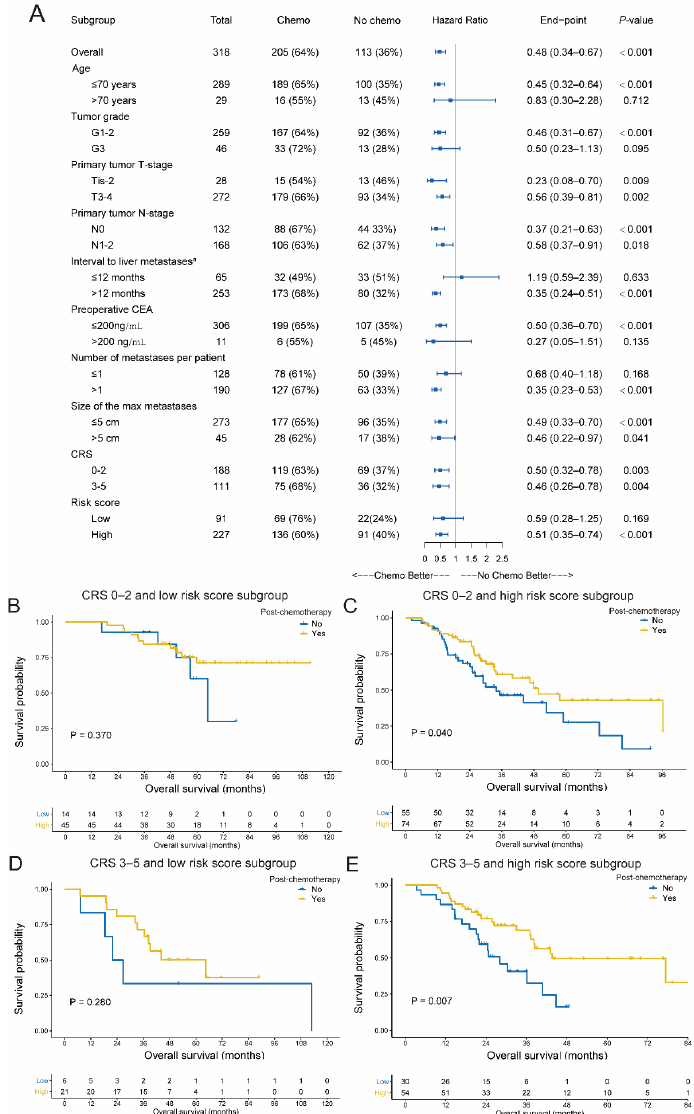
Figure 5. Subgroup analysis for the postoperative chemotherapy advantage. ( A ) The forest plot for the survival advantage for postoperative chemotherapy after CRLM resection was stratified by several clinicopathological features based on the Cox models. The HR and 95% CIs are visually presented with blue squares and error bars. ( B – D ) The postoperative chemotherapy survival advantage was assessed in four subgroups stratified by both the CRS system and 4-exosomal miRNA risk score. The Kaplan–Meier curves for overall survival for with or without postsurgery chemotherapy in CRS 0–2 and low exosomal miRNA risk subgroups ( B ), CRS 0–2 and high exosomal miRNA risk subgroups ( C ), CRS 3–5 and low exosomal miRNA risk subgroups ( D ), and CRS 3–5 and high exosomal miRNA risk subgroups ( E ), respectively. CRLM, colorectal cancer liver metastases; HR, hazards ratio; CIs, confidence intervals; CRS, clinical risk